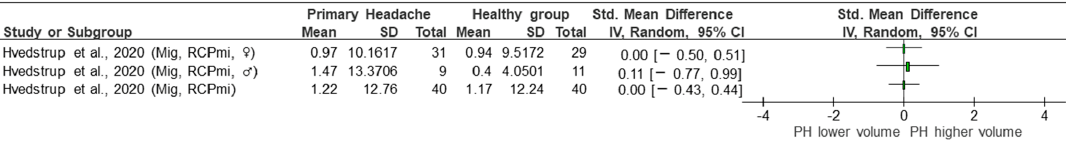
Figure 3. Forest plot of cross-sectional area based on ultrasound imaging. Graph explains the direc- tion of change in muscle size in patients with primary headache towards a lower or higher CSA. TTH: tension type headache, Mig: Migraine, CSA: cross-sectional area, US: ultrasound imaging, LC: longus colli, L: left, R: right, Lower CSA: smaller area, Higher CSA: larger area. Authors: Wanderley et al. [36] .